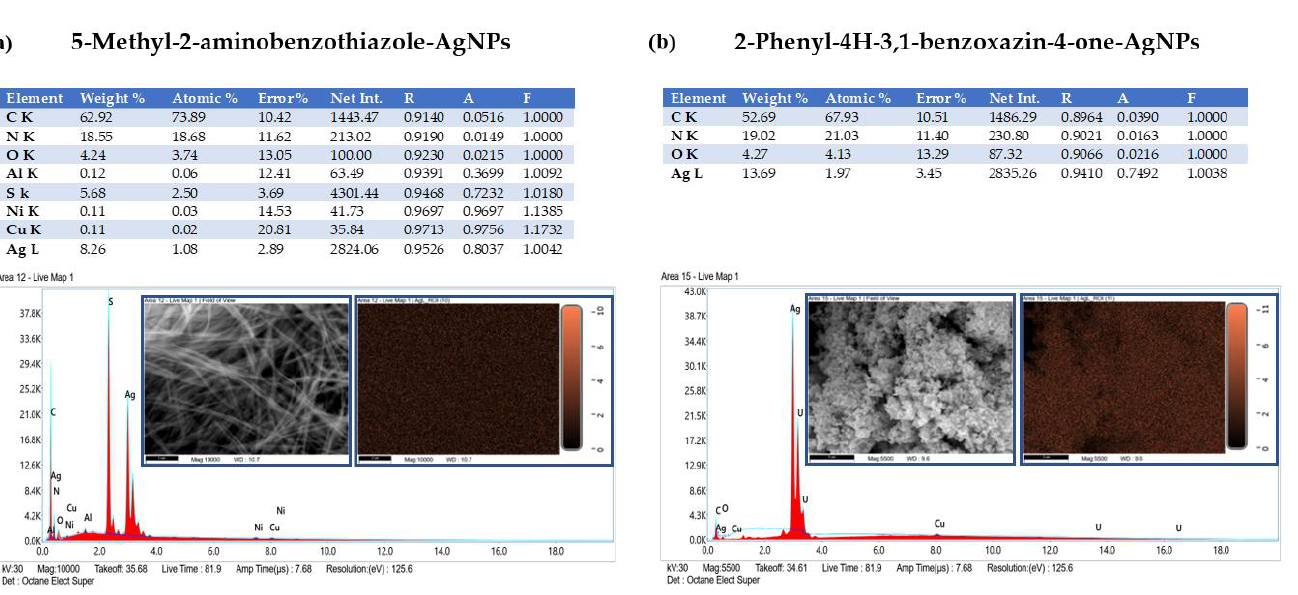
Figure 4. Representative EDAX analyses of ( a ) 5-methyl-2-aminobenzothiazole-AgNPs ( 2-np ) and ( b ) 2-phenyl-4H-3,1-benzoxazin-4-one-AgNPs ( 7-np ).